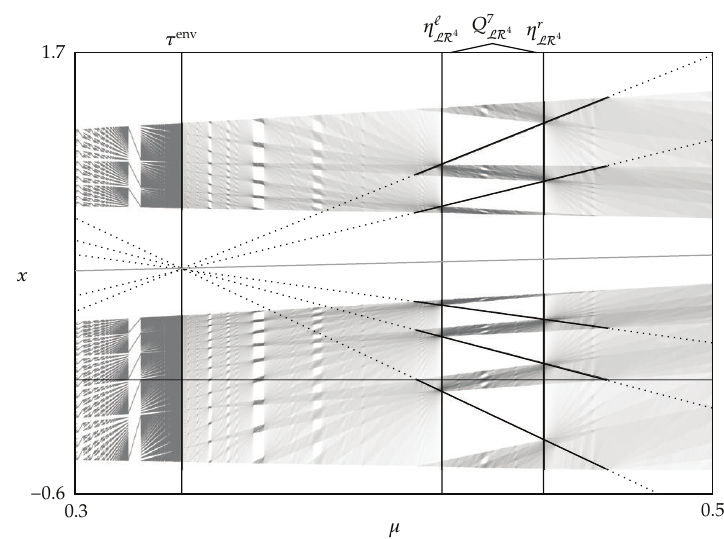
Figure 9: Numerically calculated bifurcation diagram for a (cid:6) 0 . 42, b (cid:6) − 1 . 32, μ (cid:6) 0 . 3 ··· 0 . 5. The curves show the unstable periodic orbit O LR 4 (cid:7) black lines (cid:8) , which collides with the chaotic attractor in two interior crisis bifurcations, and the unstable fixed point x R (cid:7) gray line (cid:8) , which occupies the remaining gap. Note that the orbit is destroyed through border collisions at x (cid:6) 0. Its nonexistent or virtual parts are shown dashed. The location of this scenario in the (cid:7) b,μ (cid:8) -plane is marked with A in Figure 4 (cid:7) a (cid:8)